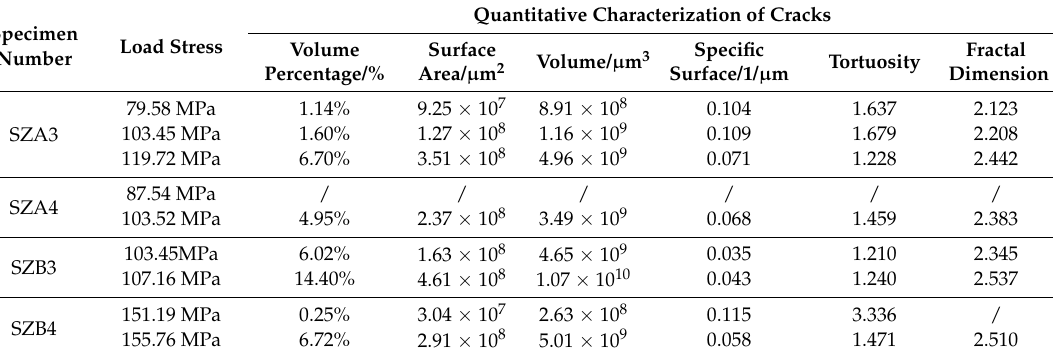
Table 2. Quantitative characterization of cracks in shale specimens.